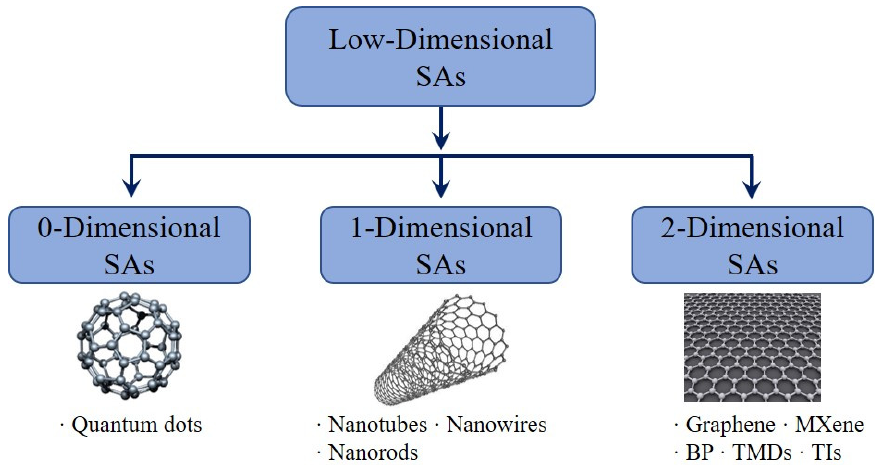
Figure 1. Low-dimensional SAs classification featured as 0D, 1D and 2D structure varieties. [Images are publicly available online].